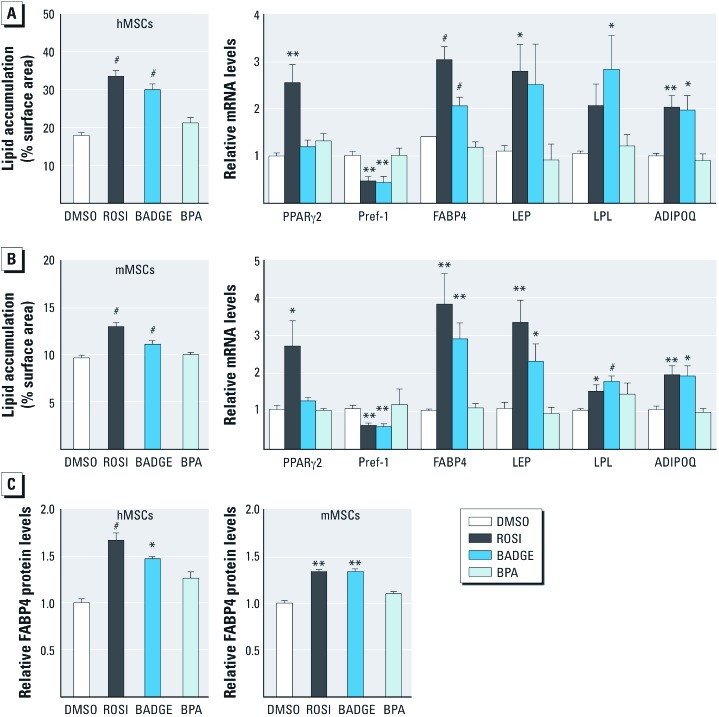
In vitro effect of BADGE exposure on the adipogenic capacities of hMSCs and mMSCs. Lipid accumulation in hMSCs (A) and mMSCs (B) (left). Adipogenesis was induced in MSCs by the addition of an adipogenic cocktail for 14 days with DMSO, 500 nM ROSI, 100 nM BADGE, or 100 nM BPA. Gene expression profile in hMSCs and mMSCs was assayed by QPCR (right) [early adipogenesis markers: PPARγ2, Pref-1, and FABP4; late adipogenesis markers: LEP, LPL, and ADIPOQ]. Expression was normalized to β-actin. (C) FABP4 protein levels were assayed by flow cytometry. Median fluorescence intensities (MFI) are represented relative to vehicle (DMSO) controls. ADIPOQ, adiponectin. All data are expressed as mean fold change ± SE in six replicates. *p < 0.05, **p < 0.01, and #p < 0.001 relative to vehicle (DMSO) controls.